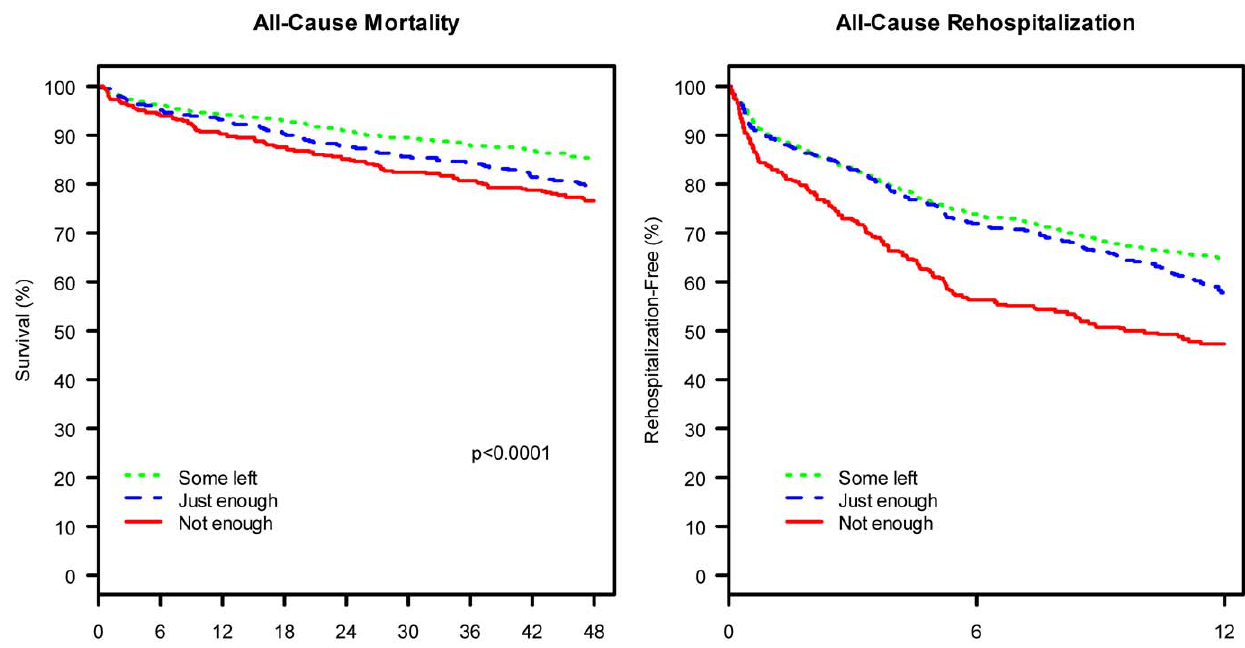
Figure 1. Kaplan-Meier Curves of All-Cause Mortality at 4-Years and All-Cause Rehospitalization at 1-Year among Patients Admitted for Acute Myocardial Infarction, Stratified by Financial Stress. Note: Kaplan-Meier Curves are Unadjusted.